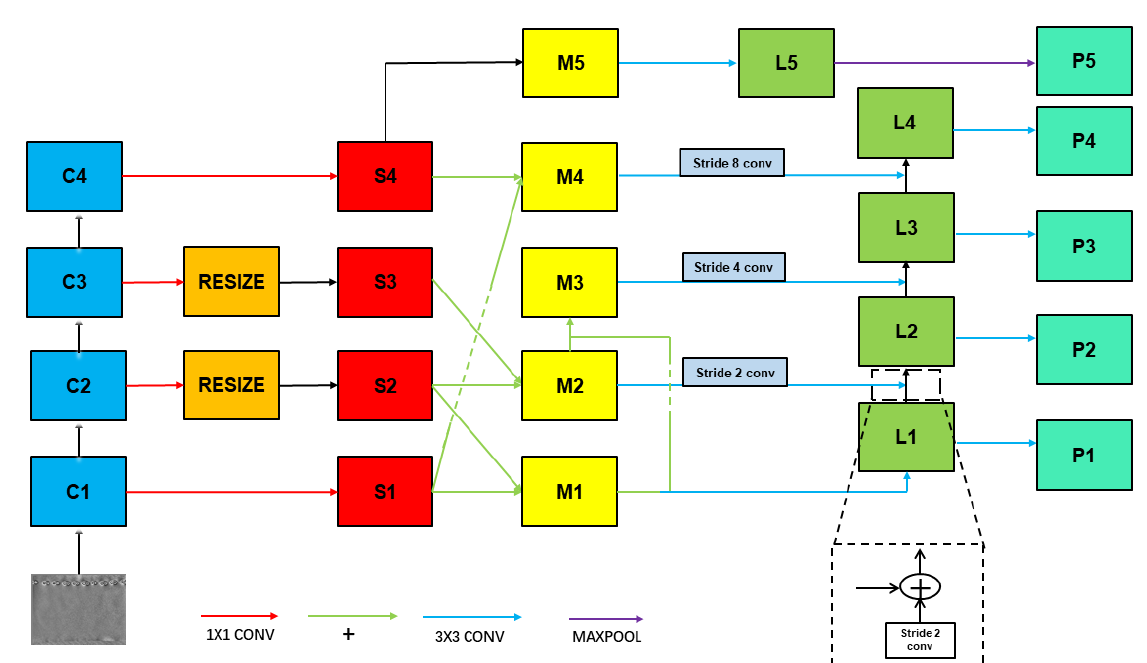
Figure 4. Tyre—Feature Pyramid Network—including a bottom-up feature extraction, a multi- directional, cross-level feature fusion, and lateral